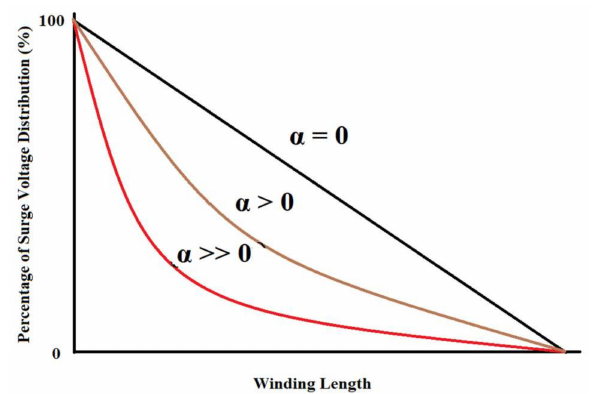
Figure 1. Illustration on the initial voltage distribution in the transformer winding